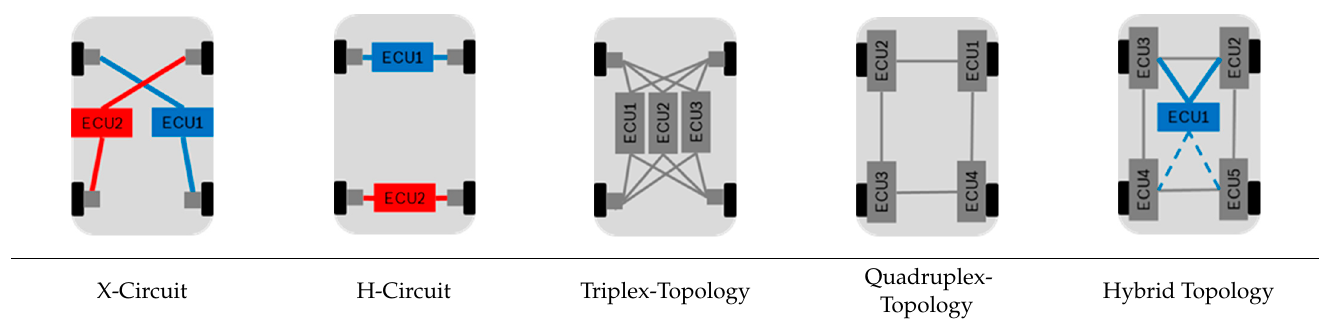
Table 8. Overview of Control Topologies.